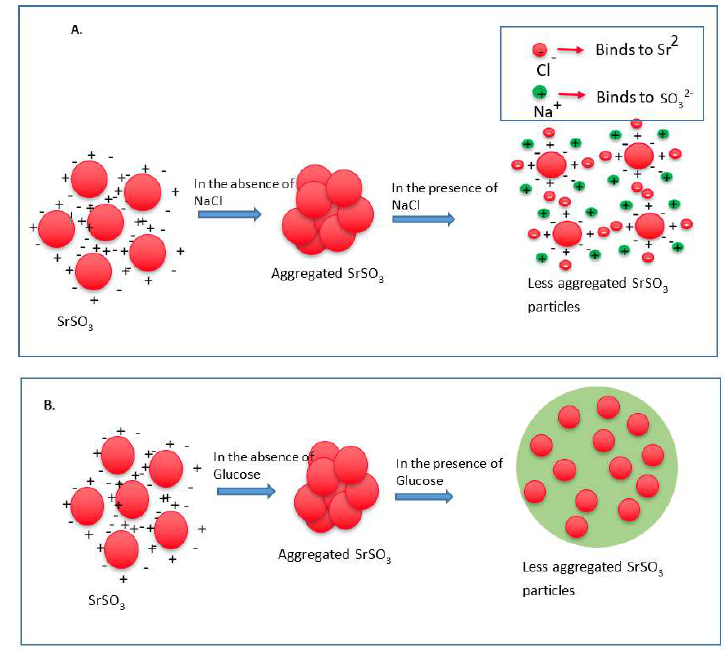
Figure 3. Schematic representation of effects of NaCl and glucose in stabilization of SrSO 3 particles. A. SrSO 3 particles stick to each other to form aggregates, while NaCl slows down the particle formation by temporally binding with Sr 2+ and SO 32− . B. Without D-glucose, SrSO 3 particles bind to each other forming large particles, but glucose lies between the particles and forms a shield to prevent particle-particle agglomeration.